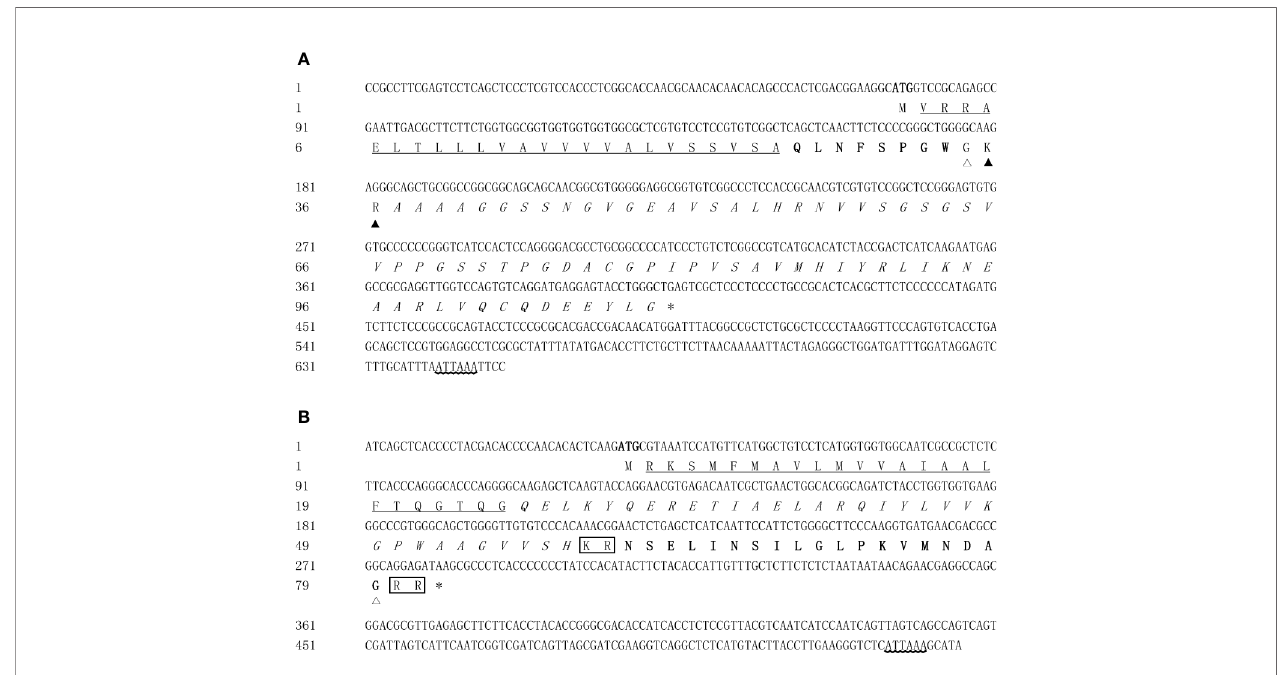
FIGURE 1 | The full-length cDNA and deduced amino acid sequences of Es-RPCH (A) and Es- b -PDH (B) in E. sinensis . The initiation codon (ATG) and stop codon (TGA/TAA) are indicated in bold and asterisk (*) respectively. The predicted signal peptides are underlined. The putative precursor-related peptides are in italics, and the mature peptides are in bold. The amidation site and potential dibasic cleavage site (KR) of Es-RPCH and two proteolytic sites (KR and RR) of Es- b -PDH are highlighted by white, black triangles and boxes, respectively. The polyadenylation signal (ATTAAA) are indicated by wave